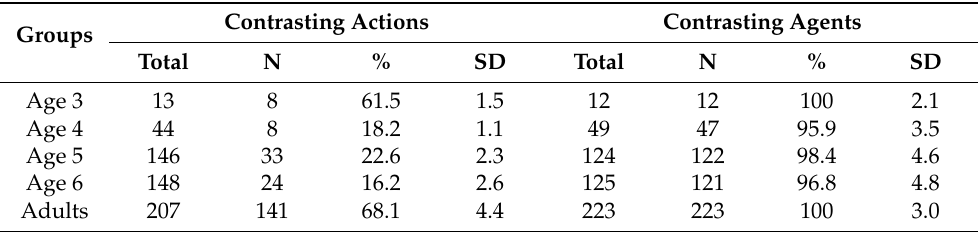
Table 9. Raw scores (N), percentages (%), and standard deviations (SD) of LONG - PASSIVES in the contrasting actions and contrasting agent contexts for each age group (out of all passive structures). Contrasting Actions Contrasting Agents Groups